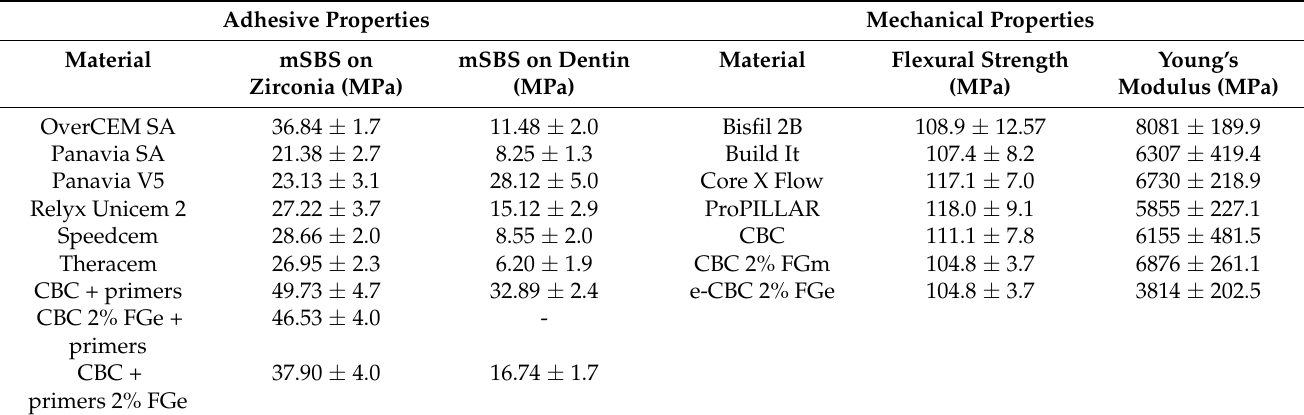
Table 4. Results of mSBS and flexural strength